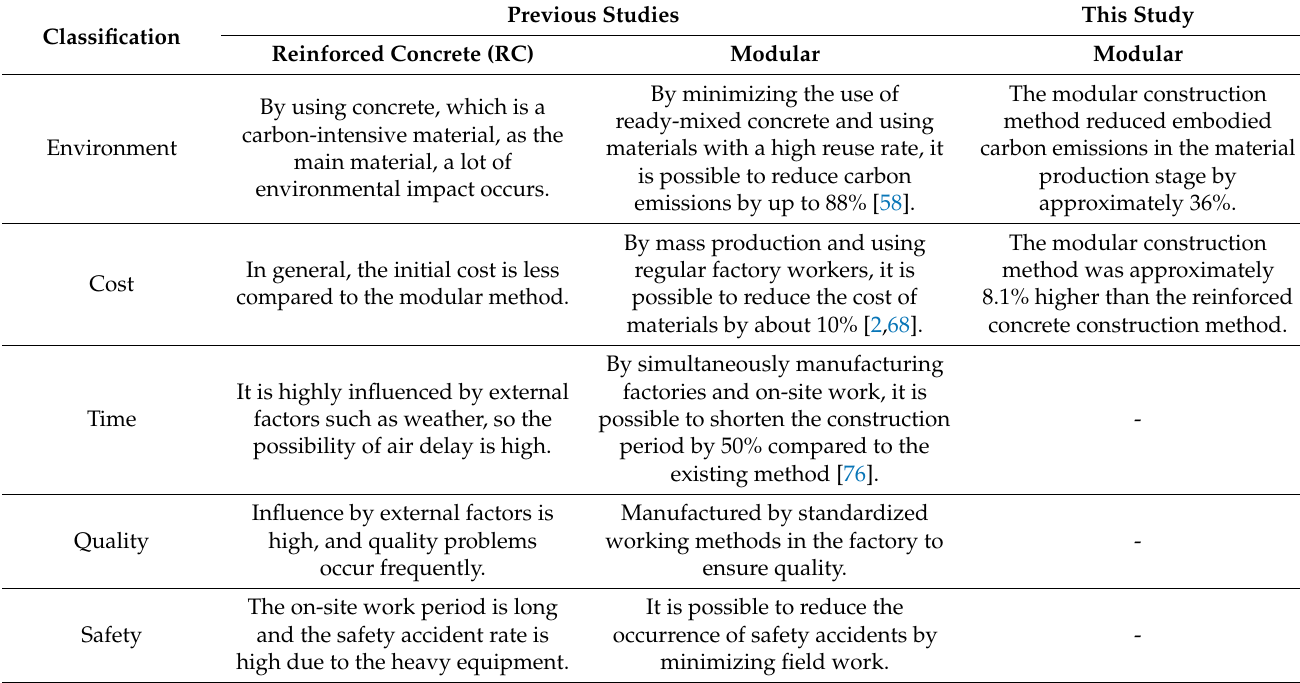
Table 7. Characteristics summary table of RC method and modular